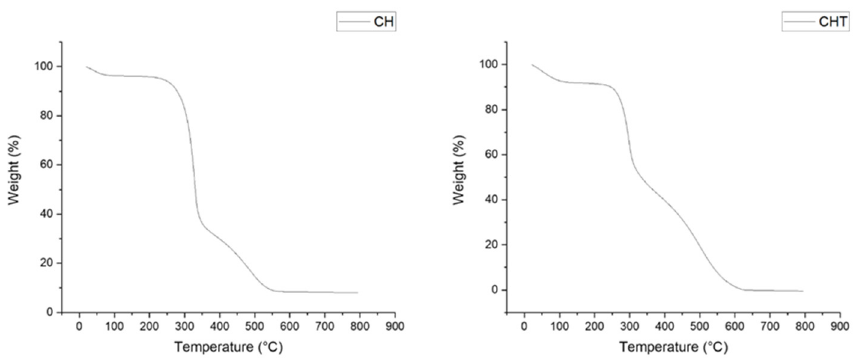
Figure 3. Thermal analysis of chitin and chitosan samples.